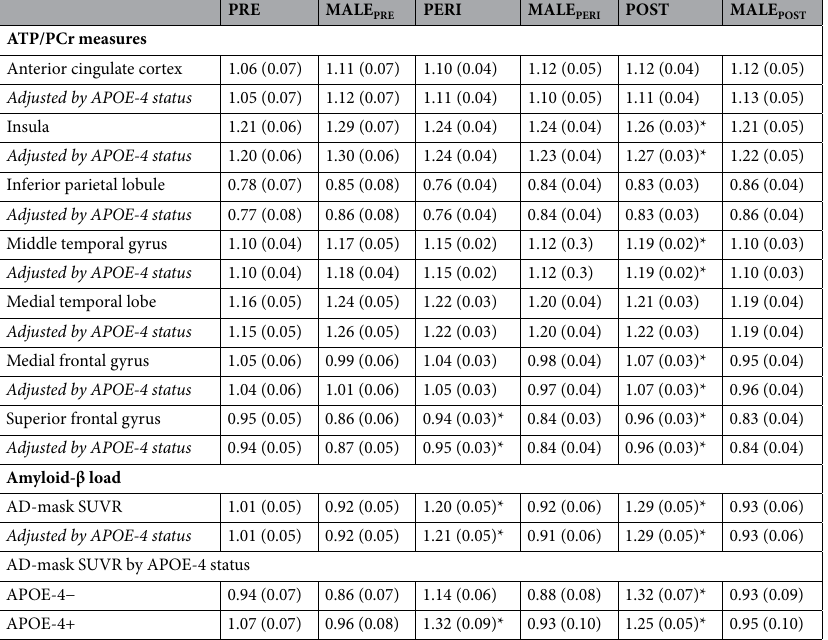
Table 3. Regions-of-interest (ROI) measures by age-matched male group comparisons. MALE PRE , males age-matched to PRE; MALE PERI , males age-matched to PERI; MALE POST , males age-matched to POST; PERI, peri-menopausal group; POST, post-menopausal group; PRE, pre-menopausal group. Values are means (SE). *Different from age-matched males, p <